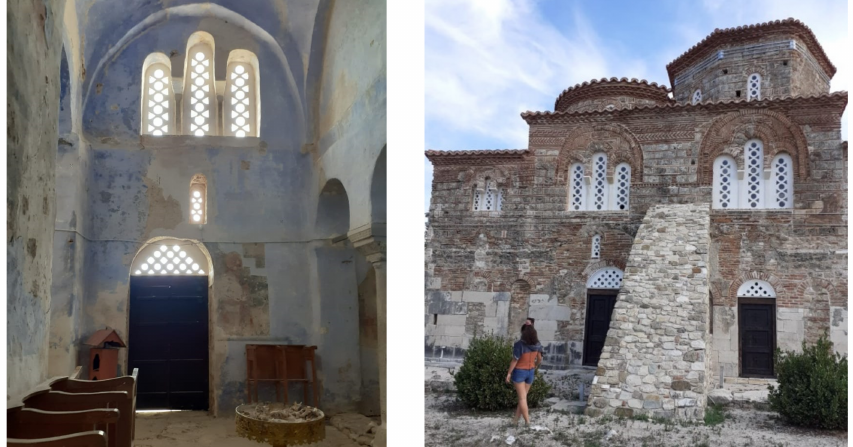
Figure 7. Internal ( left ) and external ( right ) views of St Nicholas’s church of